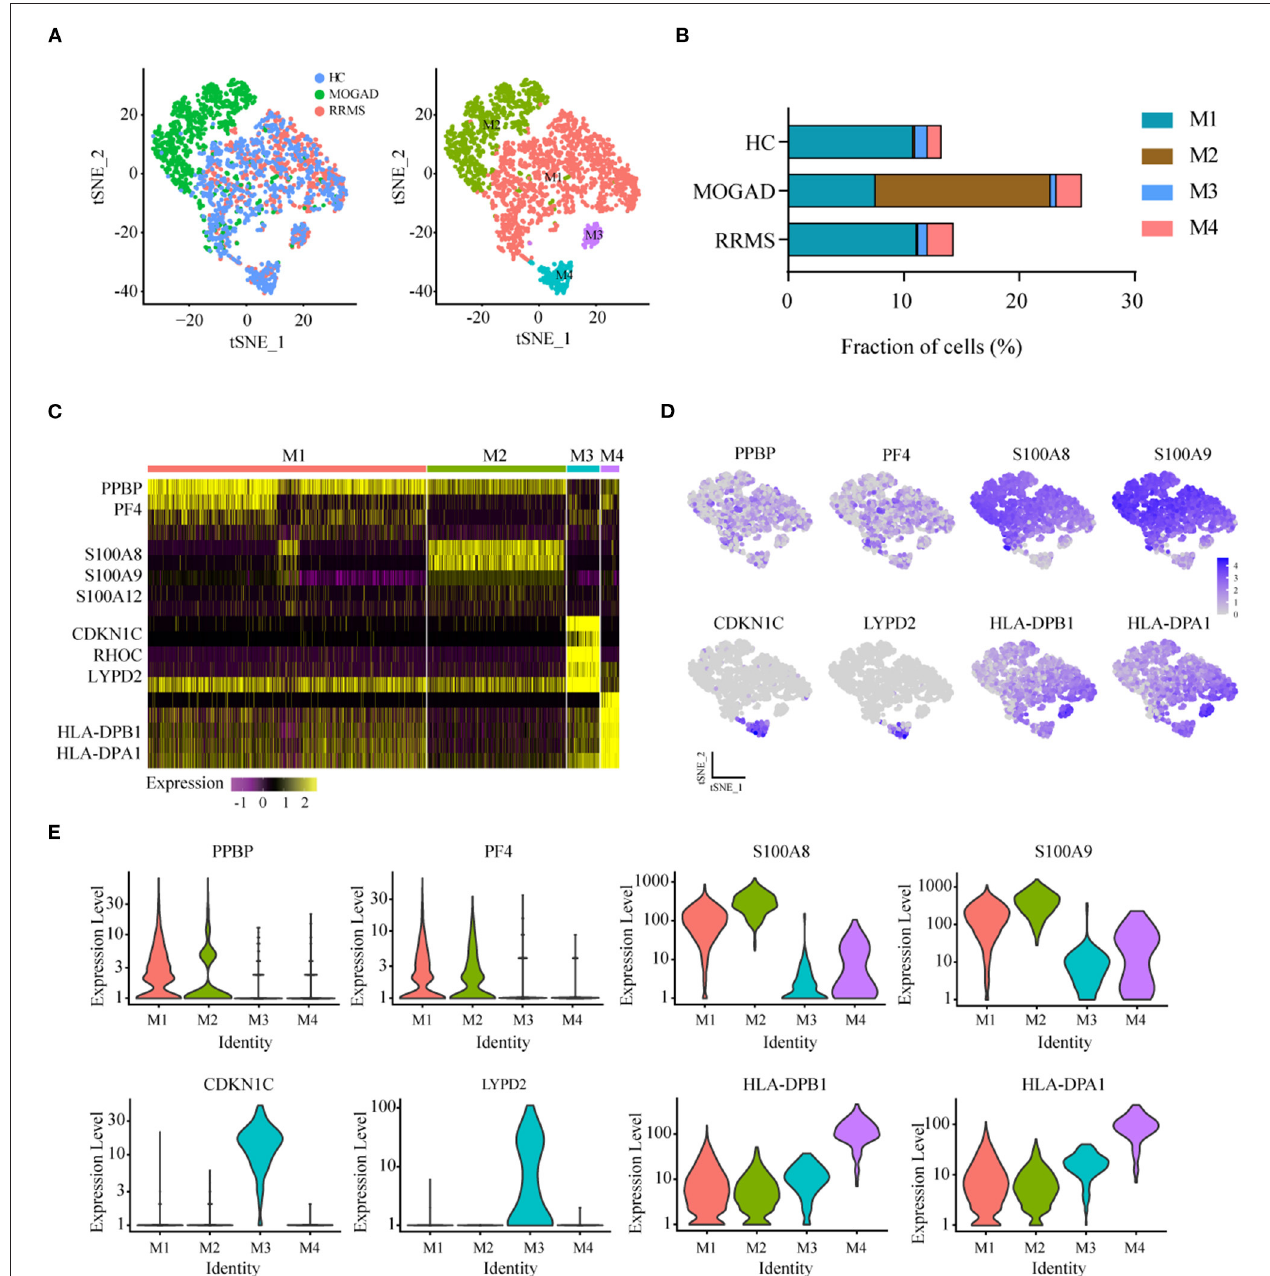
FIGURE 2 | Identification and analysis of myeloid clusters in PBMC from HC, RRMS, and MOGAD. (A) tSNE visualization of myeloid cells from HC, RRMS, and MOGAD. (B) The percentage of cells for myeloid subsets in HC, RRMS, and MOGAD. (C) Heatmaps shows the expression of the up- and downregulated markers in myeloid subsets. (D) The expression level of marker gene in each myeloid cell type was shown. (E) Violin illustration showed the expression of the marker genes from different myeloid cell types. HC, healthy controls; RRMS, relapsing-remitting multiple sclerosis; MOGAD, myelin oligodendrocyte glycoprotein (MOG) antibody-associated disease; PBMC, peripheral blood mononuclear cell; tSNE, t-Distributed Stochastic Neighbor Embedding.